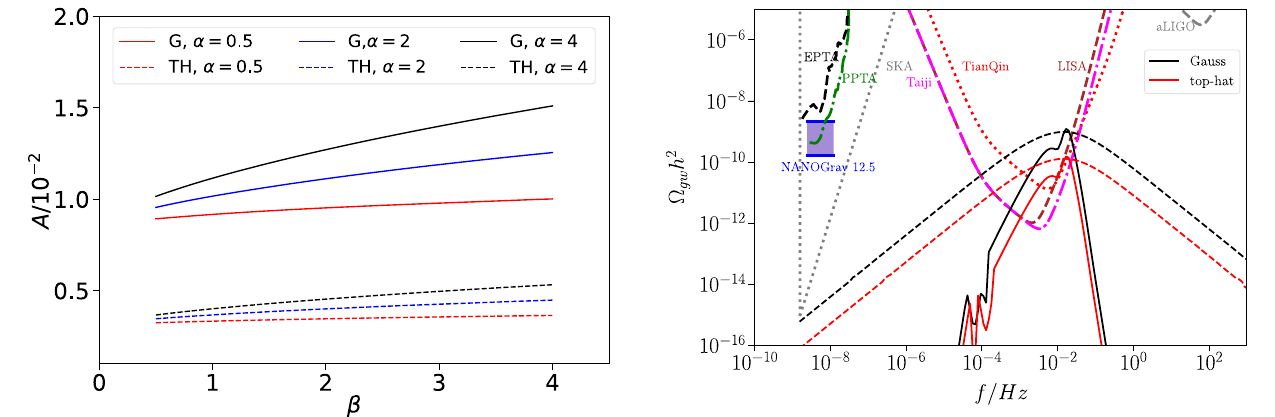
Fig. 4 The required of amplitude A to explain all the dark matter. The solid and dashed lines are the results with the Gaussian and top-hat window functions, respectively